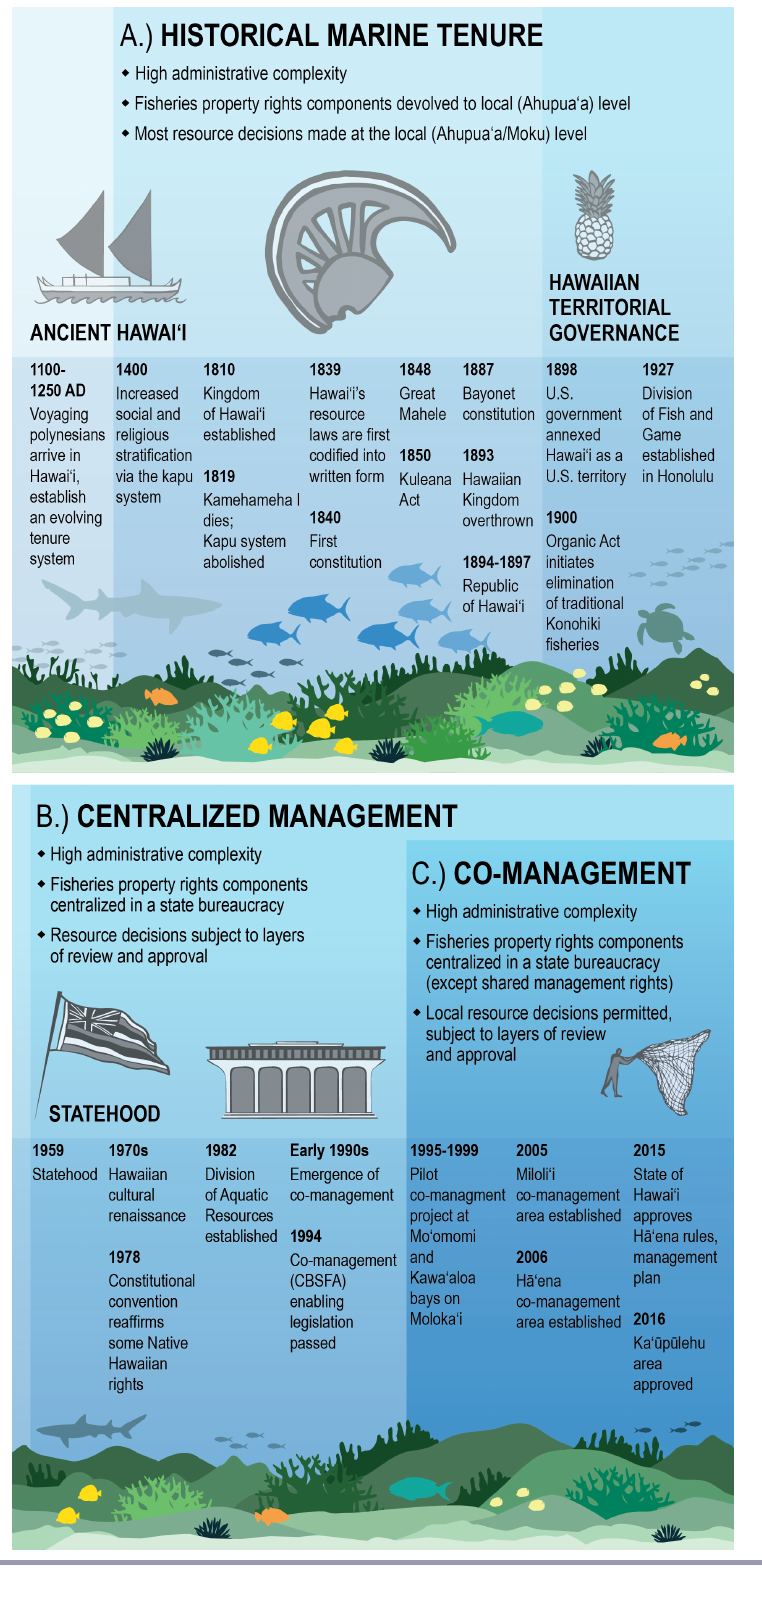
Fig. 1. Graphical depiction of historical changes and key events affecting Hawai ʻ i coral reef fisheries